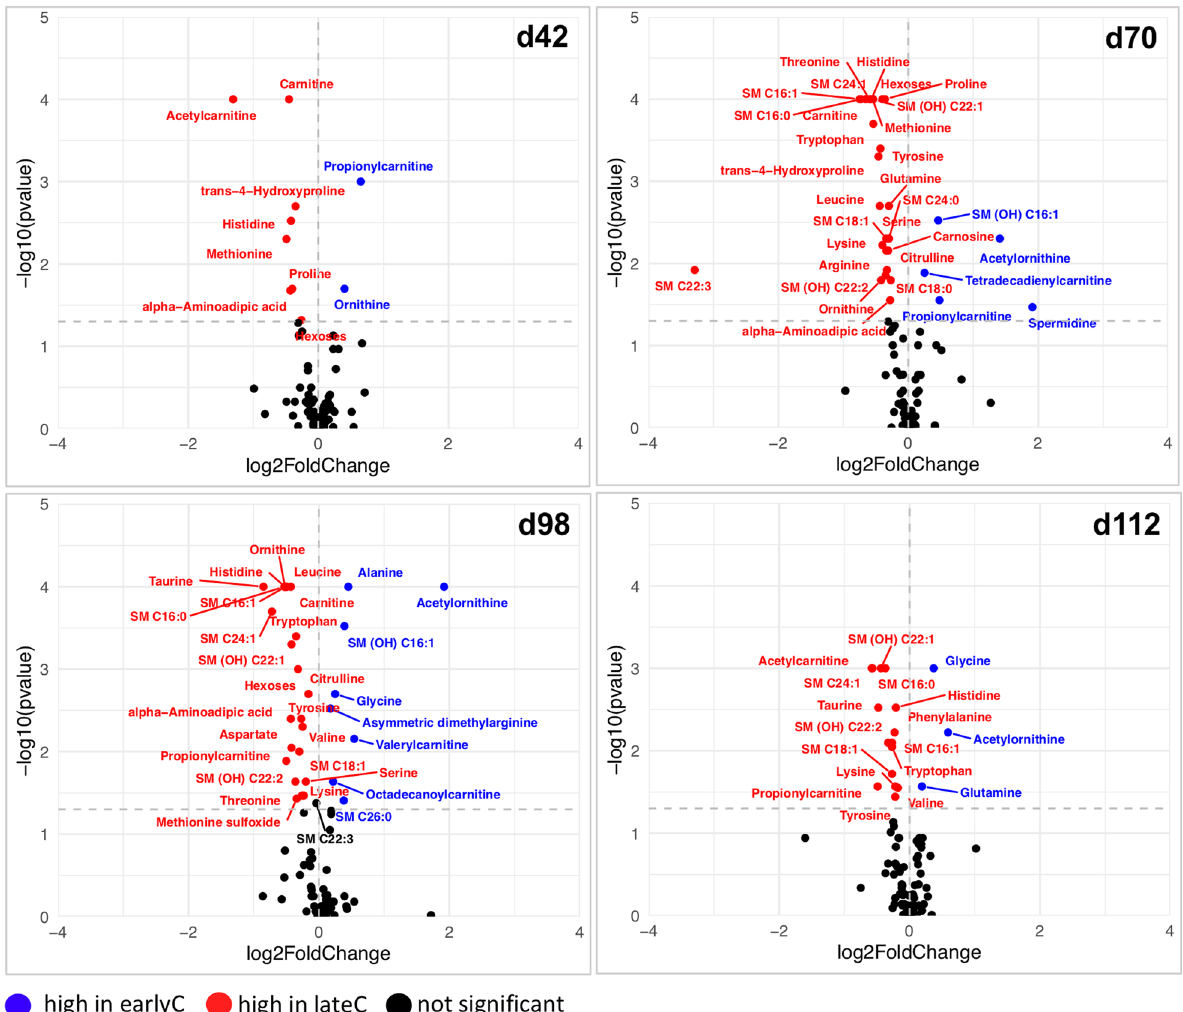
Fig. 6 Volcano plots of the weaning‑dependent changes in the plasma metabolic profiles of weaning groups. The identification of significantly altered metabolites due to weaning event within each age group was based on a VIP > 1, FDR < 0.05 ( t ‑test) and log2 FC > 0.1 or < indicates one